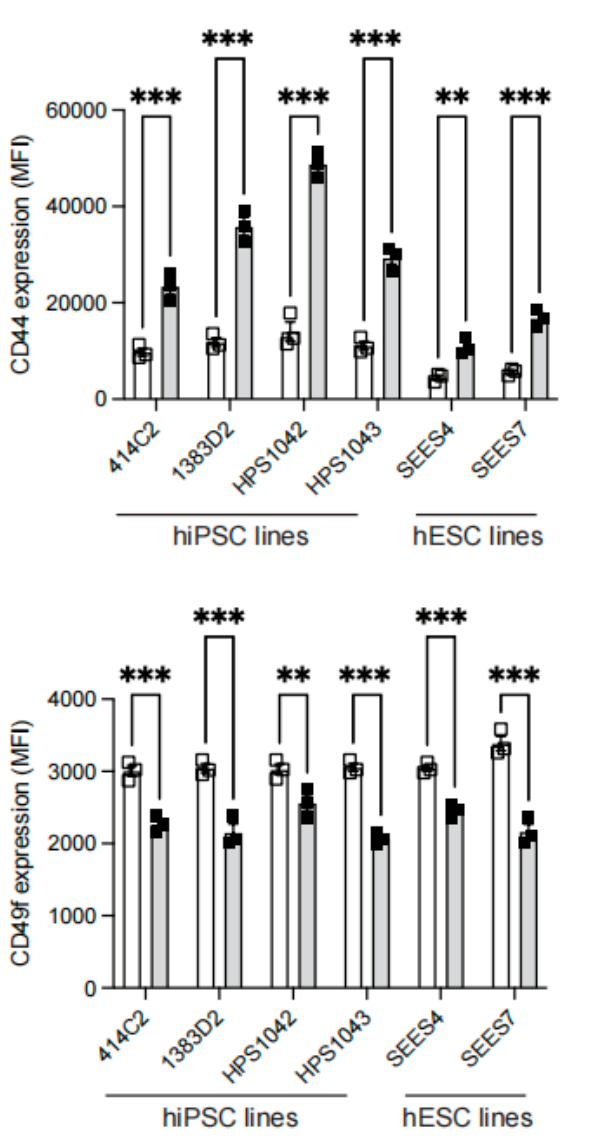
Figure 4. Quantification of the surface levels of CD44, CD140B, and CD49f among hiPSC or hESC- derived PRRX1 + LBM-like cells and PRRX1 low Day 4 cells. Comparison of mean fluorescence intensity (MFI) values of CD44, CD140B or CD49f expressed by hiPSC (414C2, 1383D2, HPS1042, and HPS1043) or hESC (SEES4 and SEES7)-derived LBM-like cells or PRRX1 low Day 4 cells ( n = 3, three biologically independent experiments). ** p < 0.01, *** p < 0.001.